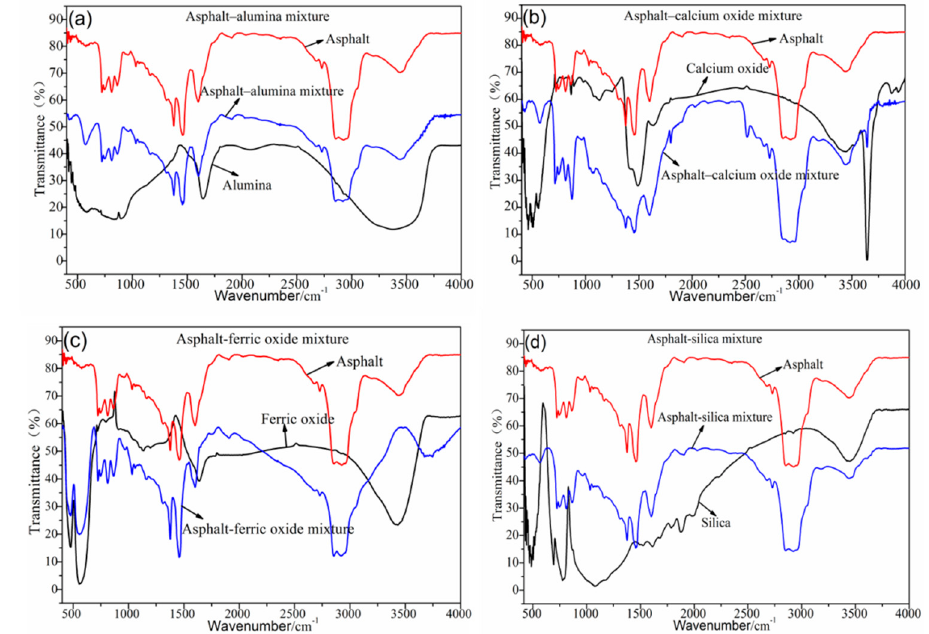
Figure 2. FTIR results of the chemical composition of the asphalt–steel slag mixture. ( a ) FTIR results of Asphalt-alumina mixture, ( b ) FTIR results of Asphalt-calcium oxide mixture, ( c ) FTIR results of Asphalt-ferric oxide mixture, ( d ) FTIR results of Asphalt-silica mixture